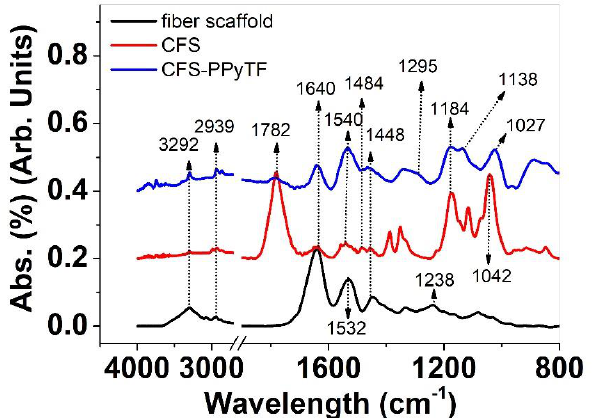
Figure 3. Fourier transform infrared (FTIR) spectra (4000–800 cm −1 ) of fiber scaffold (black), CFS (red) and CFS-PPyTF (blue).